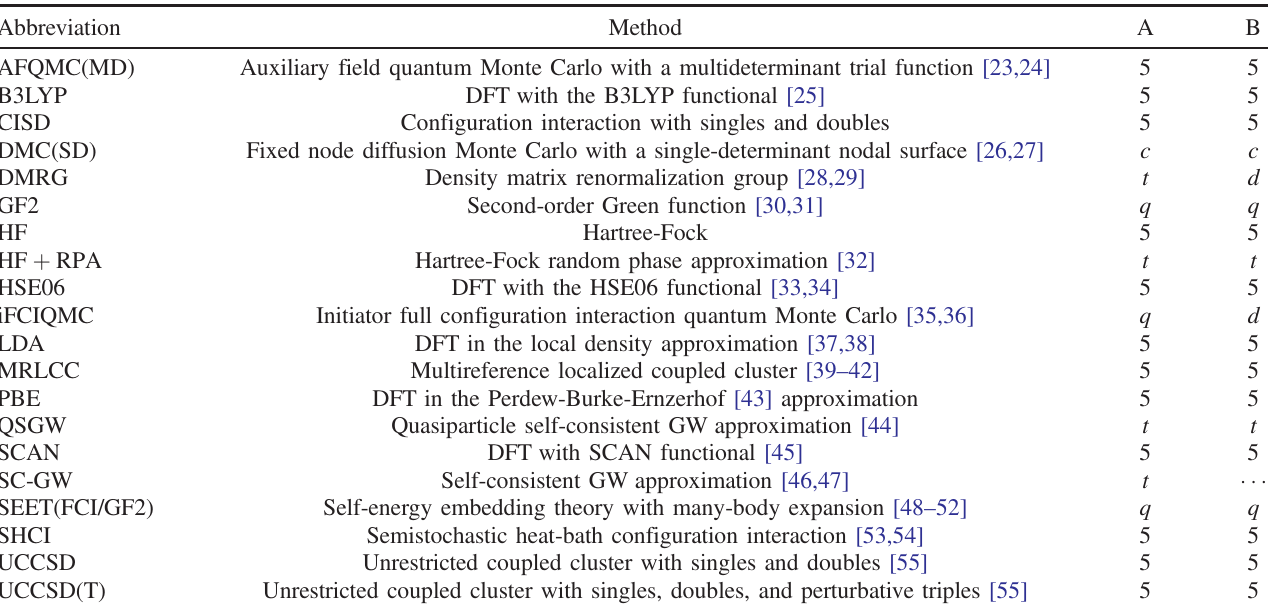
TABLE I. A list of abbreviations used in this benchmark. Details are available in Supplemental Material [22]. Column A lists the largest basis set employed by that method for at least one of the transition metal atoms, and column B lists the same for the monoxide molecules. The basis sets are abbreviated in order as d , t , q , 5, and c for complete basis